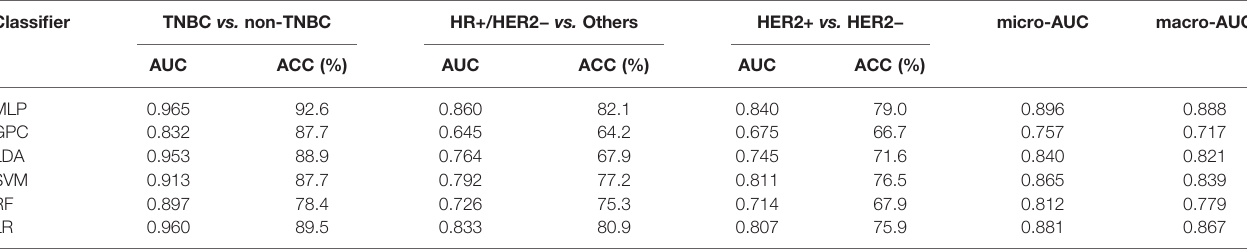
TABLE 4 | Performances of the six machine learning classi fi ers for predicting molecular subtype. Classi fi er TNBC vs.